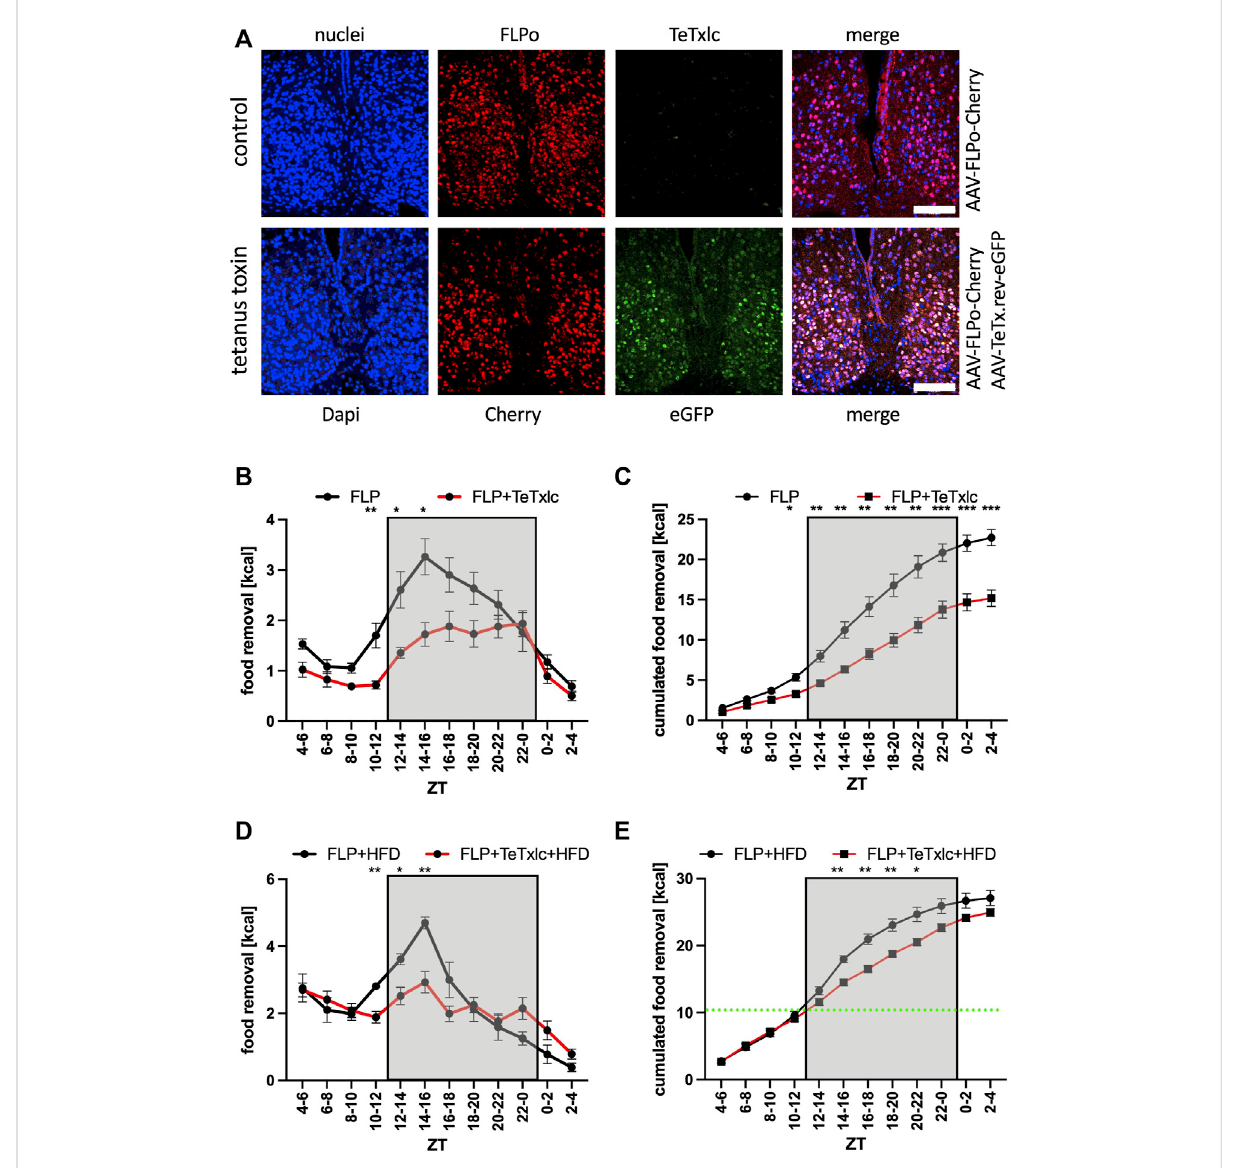
Food removal during the early activity phase is reduced by blocking vesicle release from SCN neurons expressing the tetanus toxin light chain. (A) Localization of Cherry (red) and eGFP (green) after injection into the SCN. ×40 objective (numerical aperture = 1.3, oil), a white bar measures 100 μ m. (B) Food removal in each 2 h bin starting from ZT4-6 for control mice (black), or mice injected with FLP and reversed TeTxlc (red) into both SCN regions (2-way repeated measure ANOVA, N = 12, p < 0.001, F = 27.61, DFn = 1, DFd = 22). (C) Accumulation of food removal over the course of the experiment 2B (2-way repeated measure ANOVA, N = 12, p < 0.001, F = 23.22, DFn = 1, DFd = 22). (D) Food removal of control mice (black), or mice injected with FLP and reversed TeTxlc (red) into both SCN regions with high-fat diet (2-way repeated measure ANOVA, N = 12, p < 0.01,F=8.97,DFn=1,DFd=22).Agreenlineindicatesthetransitionfromhigh-fattonormaldiet. (E) Accumulationoffoodremovaloverthecourse oftheexperiment2D(2-wayrepeatedmeasureANOVA,N=12, p < 0.001,F=23.22,DFn=1,DFd=22).Tocorrectformultipletesting,a Š idák ’